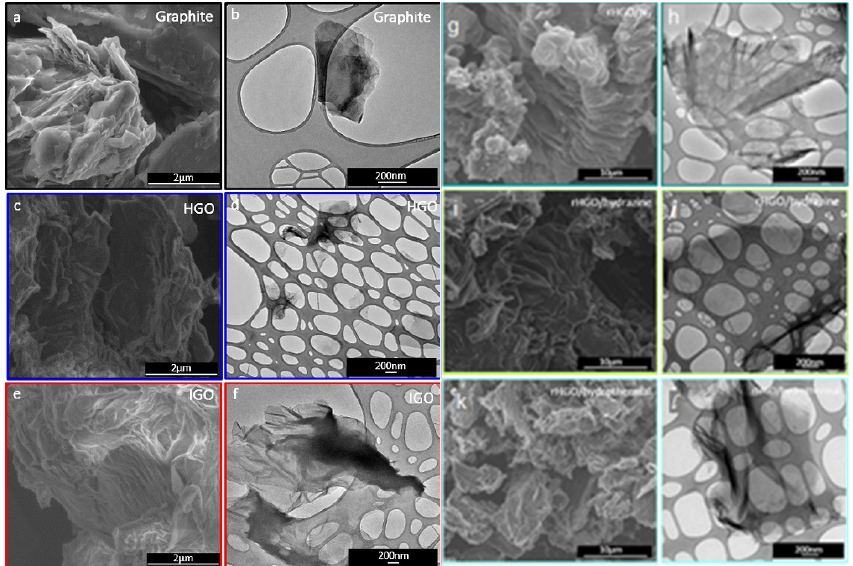
Figure 3. ( a ) SEM and ( b ) TEM of graphite, ( c ) SEM and ( d ) TEM of GO produced by Hummer’s Method, ( e ) SEM and ( f ) TEM of GO produced by improved Hummer’s method, ( g ) SEM and ( h ) TEM of rGO produced by thermal reduction in N 2 , ( i ) SEM and ( j ) TEM of rGO produced by chemical reduction using hydrazine, and ( k ) SEM and ( l ) TEM of rGO produced by solvothermal method. (Reproduced or adapted from ref. [21] , with permission from Elsevier, 2020.)